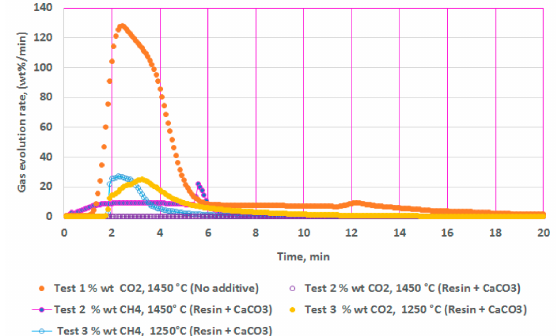
Figure 2. Gas chromatography results of isothermal calcination of: calcium carbonate (2.36 g) at 1450 ◦ C; calcium carbonate (2.36 g) + resin (2.37g) at 1450 ◦ C; and calcium carbonate (2.36 g) + resin (2.06 g) at 1250 ◦ C.